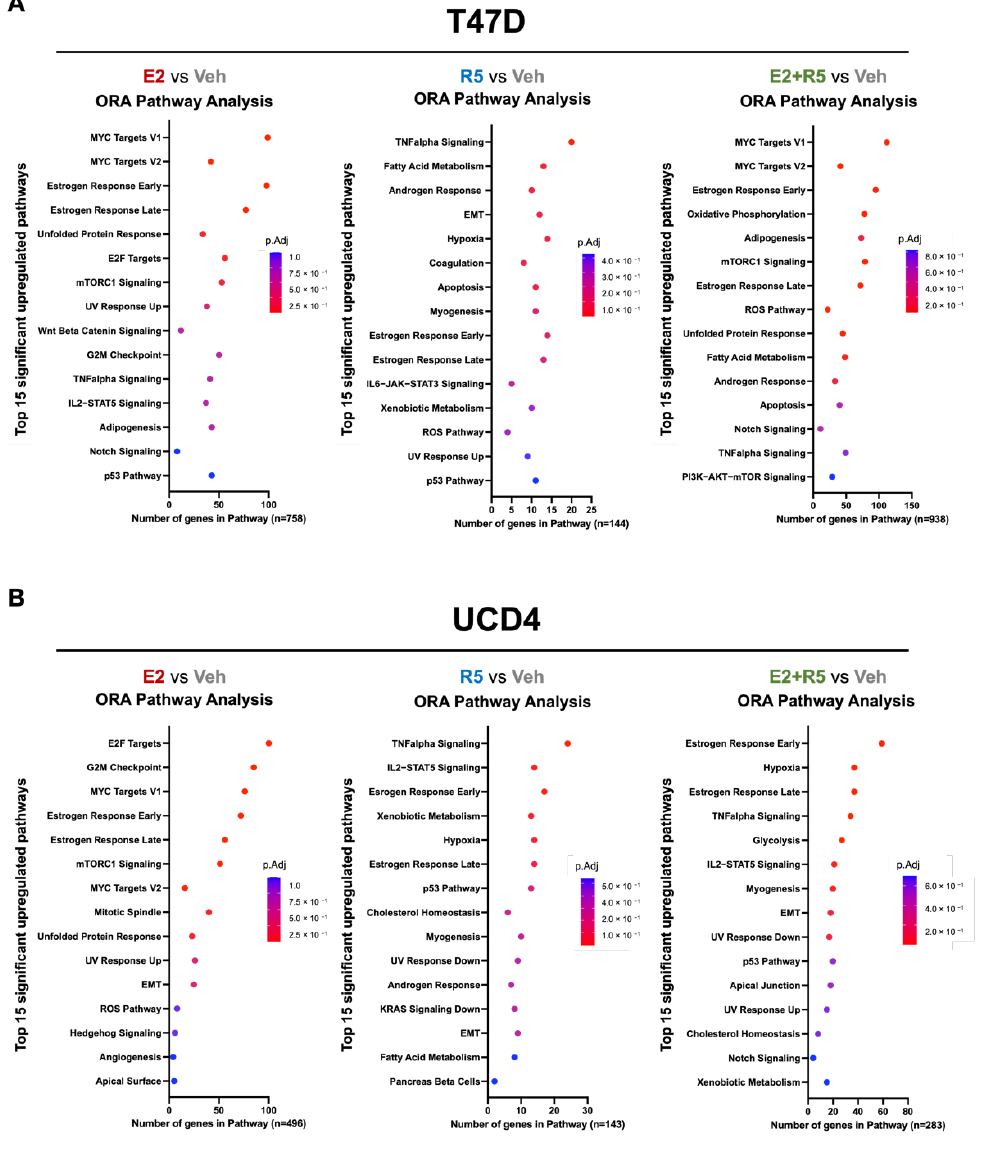
Figure 3. Estrogens and progestins transcriptionally upregulate genes associated with glycolysis, oxidative phosphorylation, and fatty acid metabolism. RNA-seq was conducted on samples of T47D and UCD4 breast cancer cell lines treated with estradiol (E2, 10 −8 M), promegestone (R5, 10 −8 M), combination (E2 + R5, 10 −8 M), or ethanol (Veh) for 24 h ( n = 3 per treatment condition). A-B) Over-representation analysis (ORA) of upregulated pathways in T47D ( A ) and UCD4 ( B ) cells for each hormone treatment compared against vehicle. Analysis conducted in CU Anschutz Genomics Core Shiny App using the Molecular Signatures Database (MSigDB) hallmark gene set collection. Tables of pathways and p -values values are given in Supplementary Table S2.